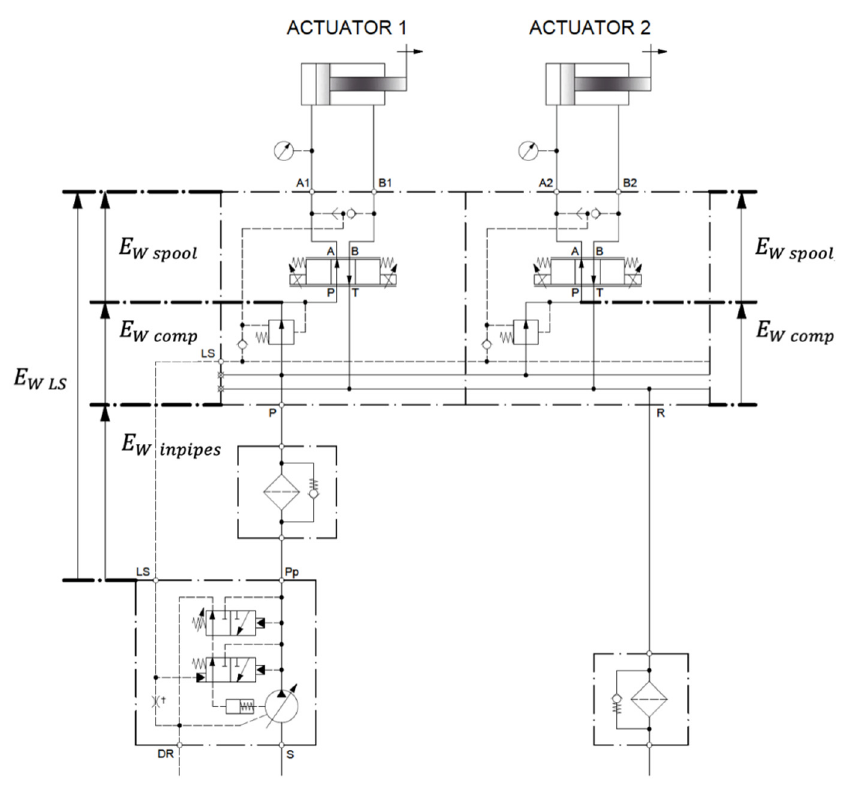
Figure 10. Hydraulic energy losses in the valve supply path.